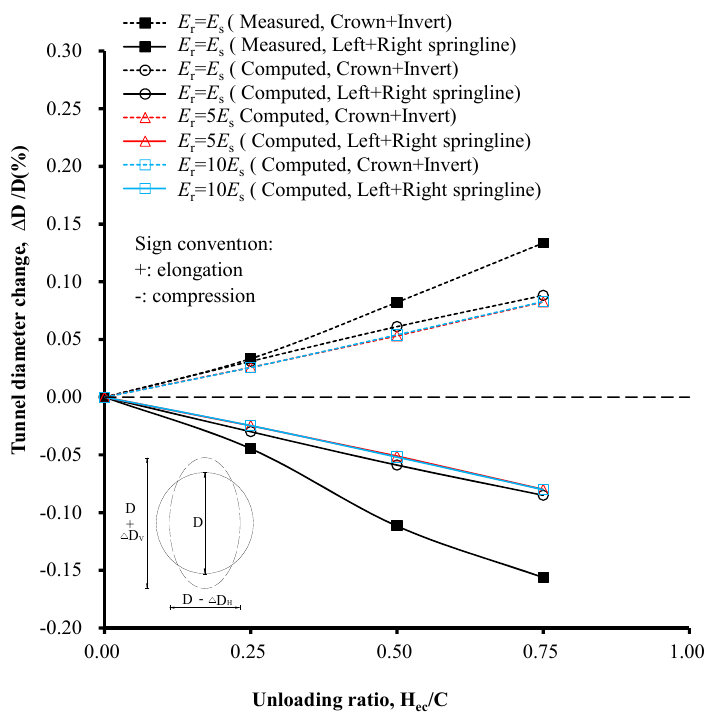
Figure 7. Measured and computed changes in tunnel diameter with different soil reinforcement